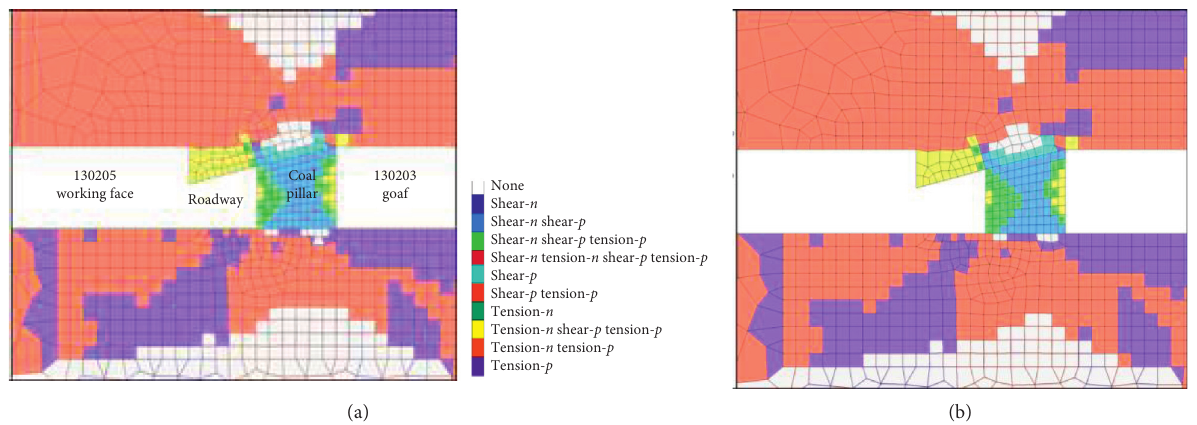
Figure 8: Distribution of the plastic zone of the rock body at the working face during stoping. (a) 150m from the cutting hole and (b) 180m from the cutting hole.